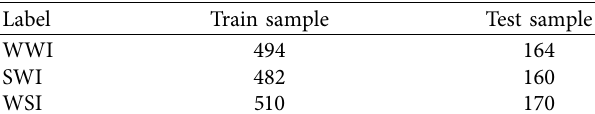
Figure 12: DVZC under diferent crossing intentions. (a) Line chart of DVZC change with time under diferent intentions. (b) Box diagram of DVZC under diferent crossing intentions. Table 2: Number of intention